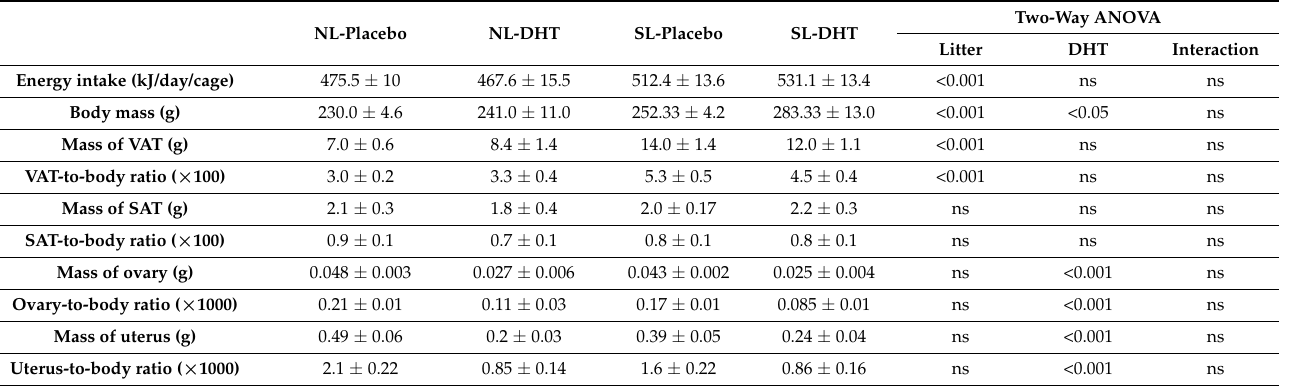
Table 1. Energy intake, body mass and absolute and relative masses of the visceral and subcutaneous adipose tissue (VAT and SAT, respectively) and reproductive organs of DHT treated and placebo rats from small litters (SL) and normal litters (NL).